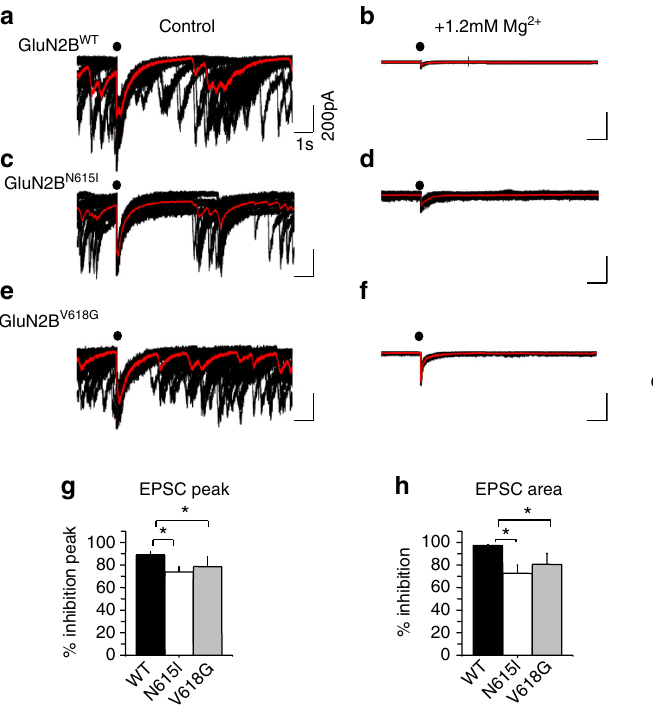
Fig. 8 Memantine inhibition of NMDAR-mediated EPSCs. Synaptic currents were recorded in 0 Mg 2+ , in the absence and presence of memantine (30 μ M for GluN2B WT and GluN2B N615I ; and 300 μ M for GluN2B V618G ) in hippocampal neurons 13 – 15 DIV expressing GluN2B WT ( a , b ), GluN2B N615I ( c , d ) and GluN2B V618G ( e , f ). Bar graphs report the percentage inhibition of mean peak EPSC amplitudes, one-way ANOVA p > 0.05 ( g ), and the area under the evoked EPSCs ( h ). Calibration in a applies to b –